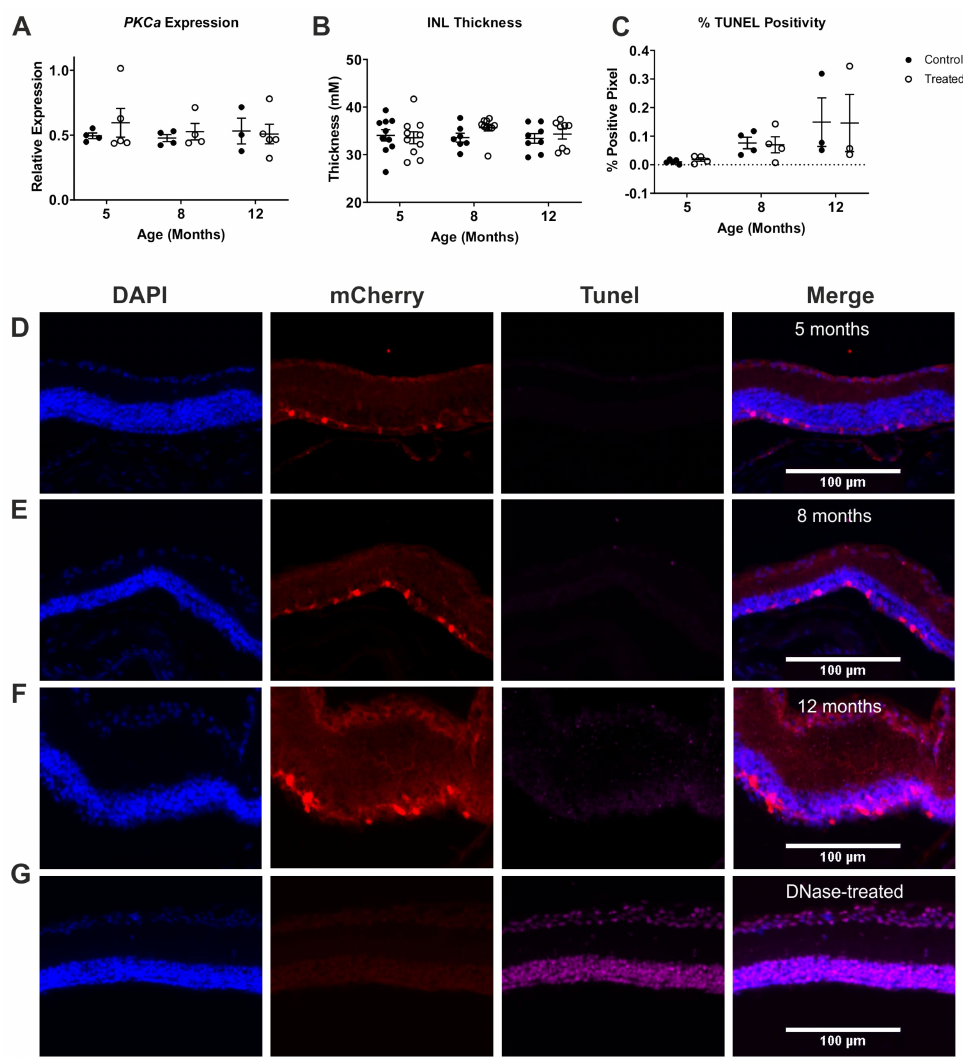
Figure 3. Toxicity study on a cellular level of rod opsin-treated Grm6 Cre rd1/rd1 retinas. ( A ) PKC α expression in rod opsin-treated and control rd1/rd1 mice. ( B ) INL thickness of rod opsin-treated and non-treated control rd1/rd1 mice ( C ) Levels of apoptosis (TUNEL positivity) within the INL of rod opsin-treated and control rd1/rd1 mice. ( D – F ) Representative images of mCherry and TUNEL co-localisation at 5 months of age ( D ), 8 months of age ( E ), 12 months of age ( F ) and a DNase-treated positive control ( G ). No effect of the treatment was found on the INL thickness (two-way mixed ANOVA p > 0.05); or on the PKCa expression (two-way mixed ANOVA p > 0.05). Across the INL, the positive pixel count was always low (< 0.4%), but this did increase with age, and time was shown to have a significant effect (two-way mixed ANOVA, p < 0.05). Importantly, however, the levels of apoptosis were not impacted by treatment (two-way ANOVA, p >